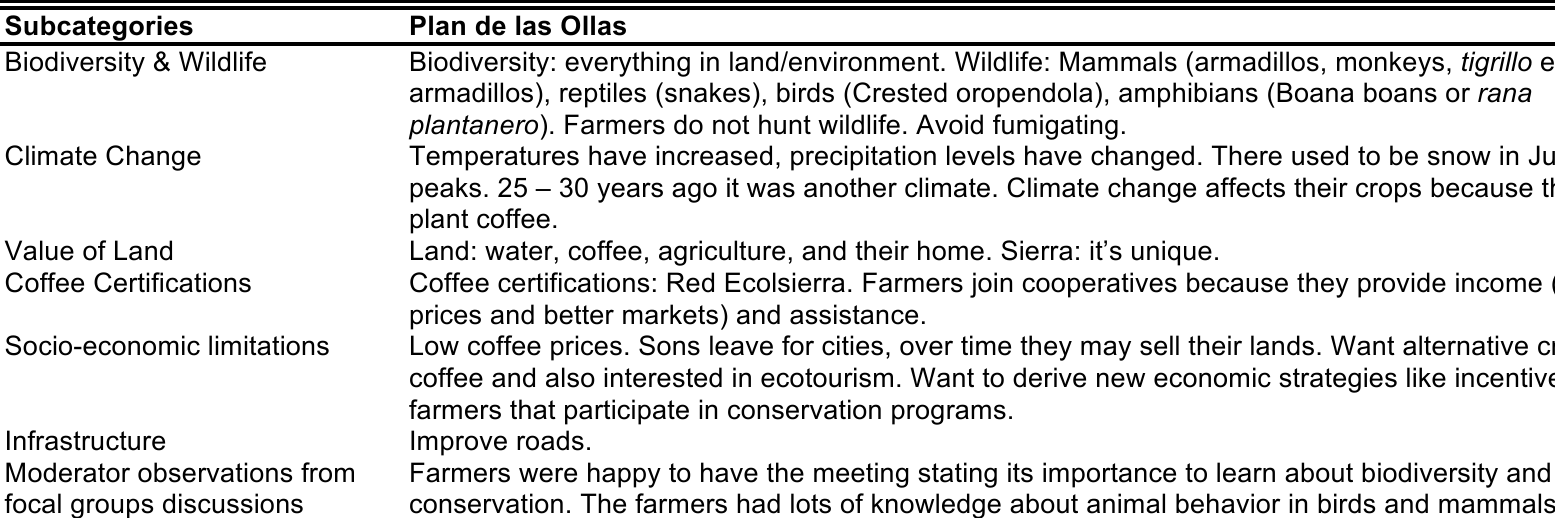
Table A2.2 The community of Plan de las Ollas (n=7) presented